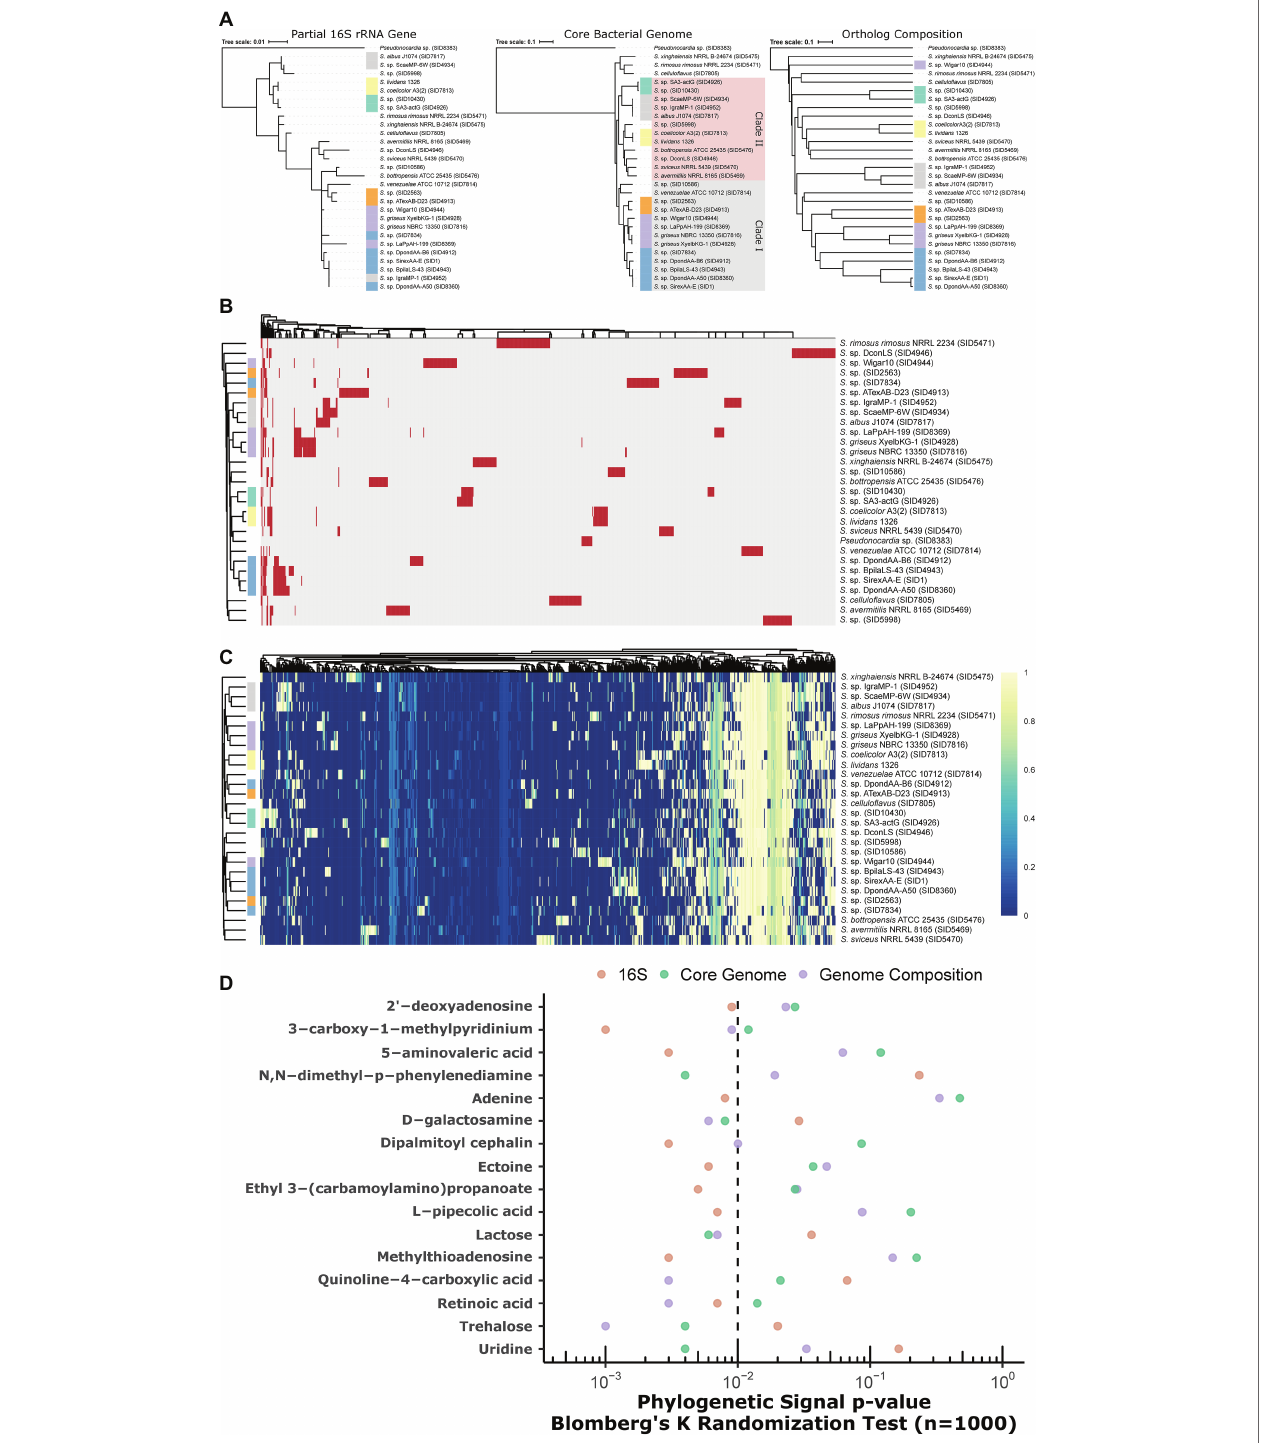
FIGURE 6 | (A) Discordant relationships between Streptomyces by different methods, partial 16S (V3 and V4), core genome phylogeny, or Jaccard similarity of genome composition (orthologs). (B) Presence/absence heatmap of biosynthetic gene cluster families (GCFs) in Streptomyces . Rows = strains, columns = GCFs. red = present; gray = absent. (C) Genome-metabolite MAGI scores (colors; scaled 0 to 1) in Streptomyces . Rows = strains; columns = reactions; clustering = Euclidean. (B,C) Annotation bar for strains (colors on row dendrogram) correspond to clades designated in (A) above. (D) Phylogenetic signal of metabolites with respect to trees in (A) above. Significance is marked by p < 0.01 (left of the dashed